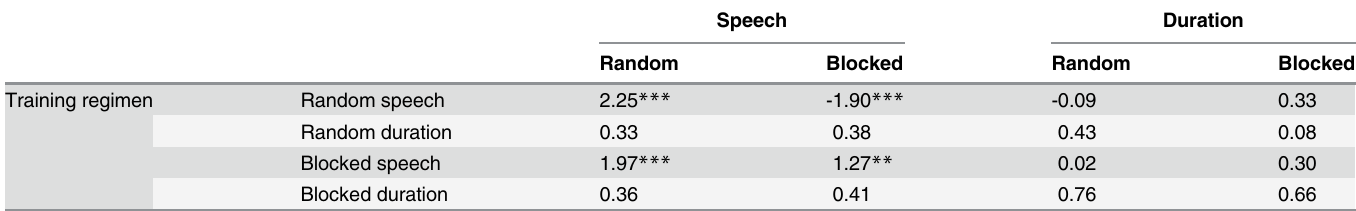
Table 2. Pre- to post-test learning vs. untrained controls in Z-score